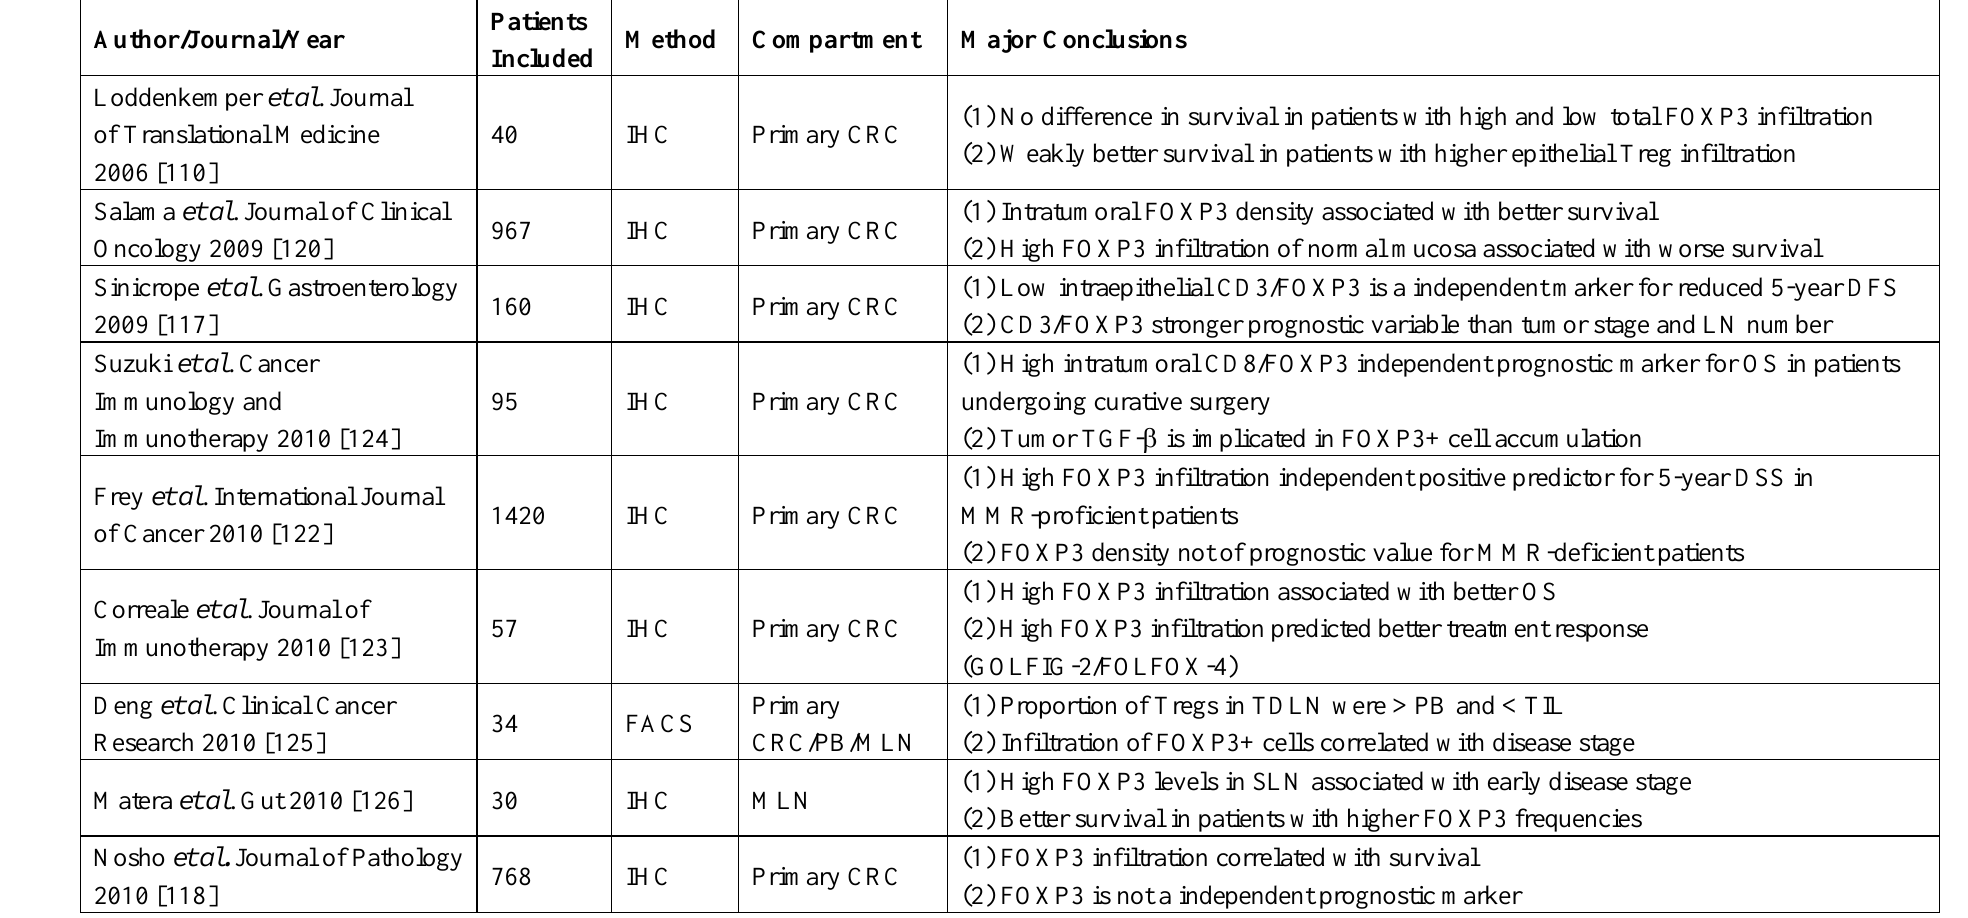
Table 1. Clinical Studies on the Impact of Regulatory T Cells in Disease Course and Outcome of Colorectal